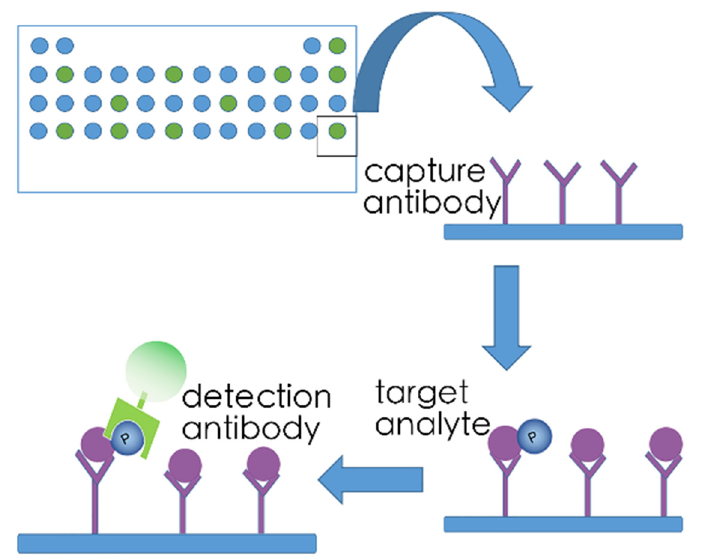
Figure 3. Phospho-kinase antibody array. Using specific capture antibodies spotted onto nitrocellu- lose membranes, the proteome profiler antibody array binds selected kinases when these membranes are incubated with experimental samples. A horseradish-peroxidase-coupled detection antibody, which recognizes phosphorylated tyrosine is added. Kinases are subsequently visualized by chemiluminescent detection reagents.